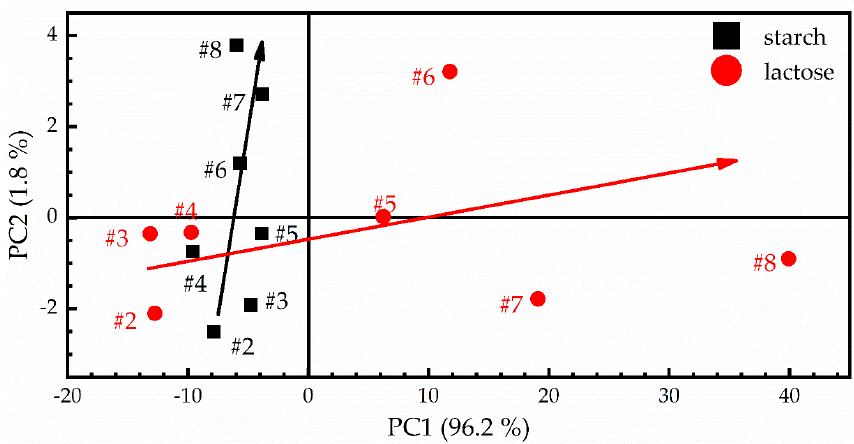
Figure 8. Scores diagram constructed from the LIBS spectra of the two samples’ sets containing starch and lactose. The numbers near the data points denote samples with different sulfur concentrations (see Table 1). The black and red arrows are indicating the samples’ distributions in the Principal Components plot.